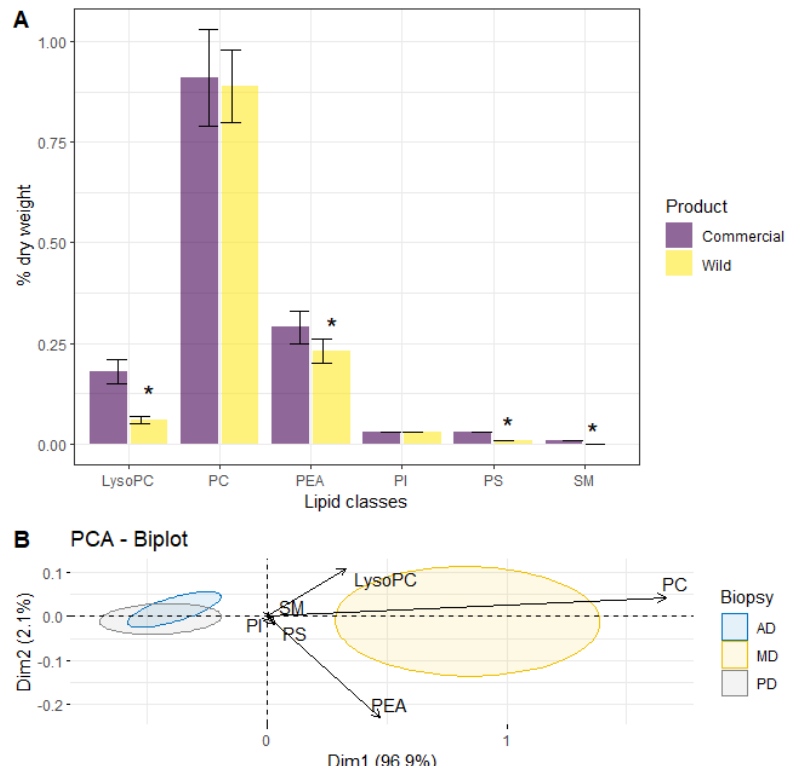
Figure 6. The content of individual phospholipid classes in muscle tissue from the wild and com- mercial North Atlantic beaked redfish Sebastes mentella . Note: ( A )—comparative characteristics of the content of individual phospholipid classes in wild and commercial fish; ( B )—principal compo- nent analysis for different biopsy regions in “commercial” fish (AD, MD, and PD); *—significantly ( p ≤ 0.05) different between wild and commercial product.